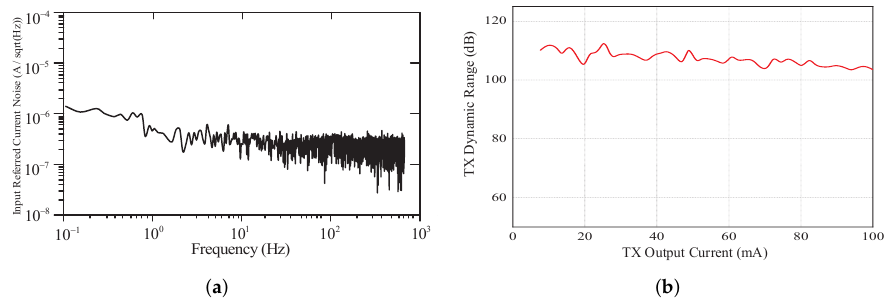
Figure 14. ( a ) The input current noise spectrum of TX. ( b ) The DR of TX in the varying output current. Dual-wavelength recording is used to measure the PPG response on the index finger of a male subject. The LEDs were biased with a 25 mA peak current with a 25% duty- cycle. Figure 15a shows the output of the dual-wavelength lights (660 nm and 940 nm), clearly showing two PPG waveforms. Each cycle of the PPG wave represents a heartbeat, which is roughly one beat per second. The systolic and diastolic peak can be distinguished and the distance between these two peaks can be used as an indicator for the aging of the heart. The spectrum of the 660 nm red light PPG signal is shown in Figure 15b, and its fundamental frequency describes the HR. The PI can be obtained from this spectrum diagram as lower than 1%. Furthermore, two PPG waves of R and IR can be used to calculate the S P O 2 .